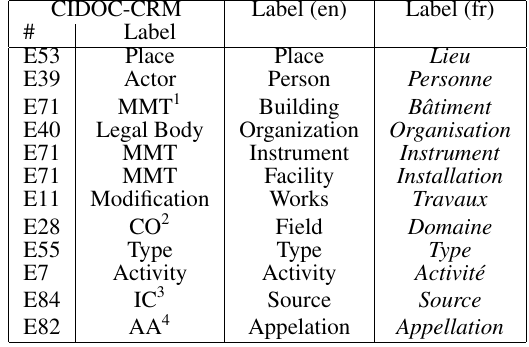
Table 1. Types of entities in the data model used in the early